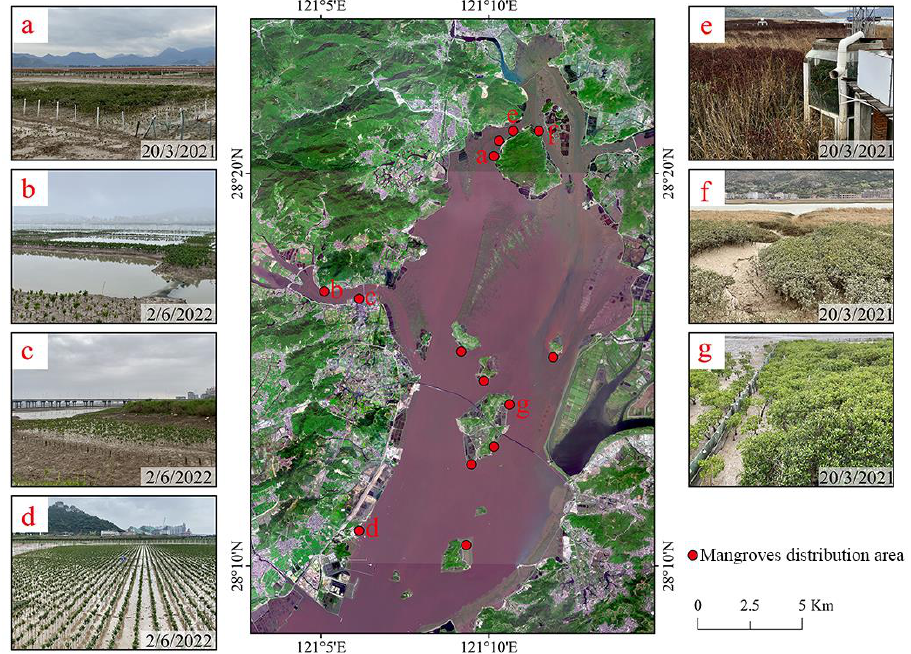
Figure 10. Distribution of mangroves in Yueqing Bay. ( a ) The protective net was set to prevent the invasion of S. alterniflora . ( b – d ) New mangrove afforestation area. ( e ) Mangrove groups are sheltered in the glasshouses on Ximen Island and mangrove crowns withered because of strong cold waves outside the glasshouses. ( f ) S. alterniflora invaded the mangrove area. ( g ) Mangrove area located on Maoyan Island.